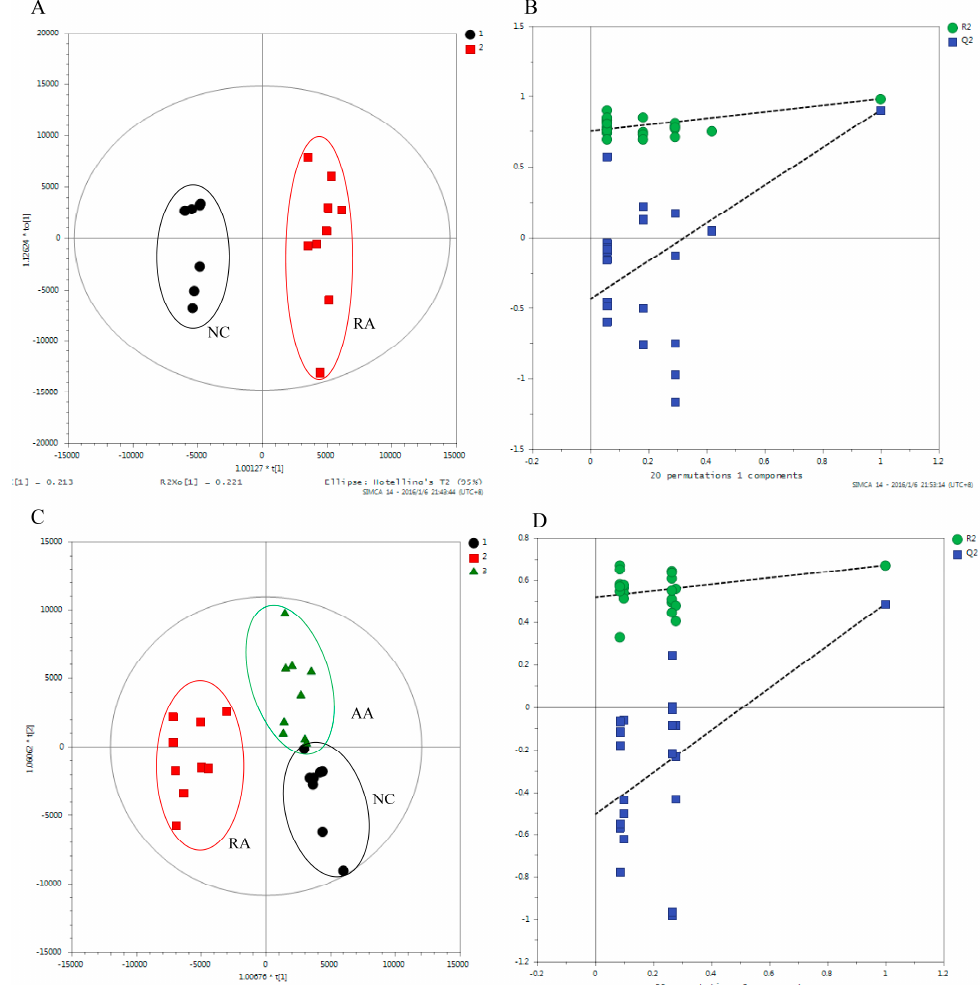
Figure 4. PLS-DA score plot and validation of PLS-DA model of urine samples from the rats. ( A ) PLS-DA score plot of NC and RA group; ( B ) validation of PLS-DA model of NC and RA group; ( C ) PLS-DA score plot of NC, RA and AA group; ( D ) validation of PLS-DA model of NC, RA and AA group. (NC represents control group; RA represents model group; AA represents the Aconitum carmichaeli + Ampelopsis japonica -treated RA